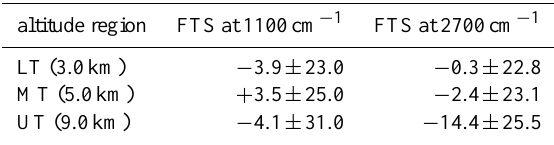
Table 5. Relative difference between our IASI and FTS H 2 O prod-